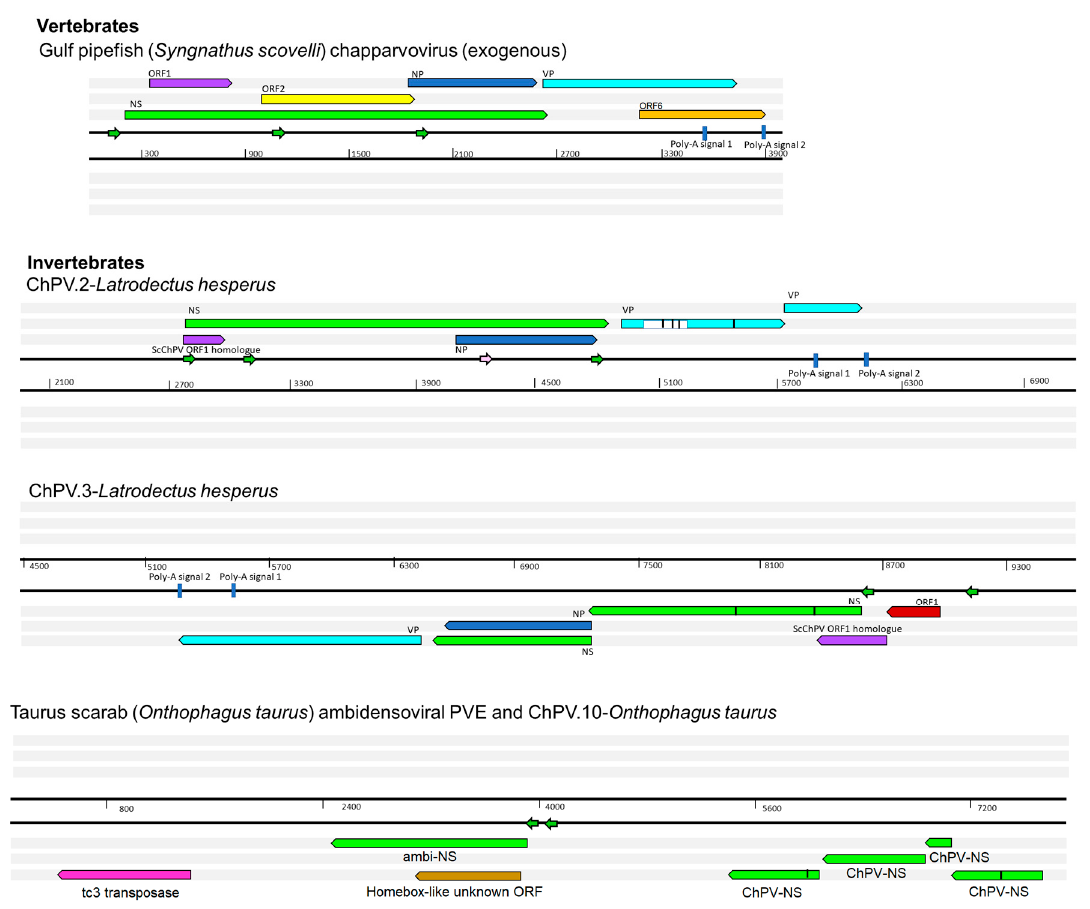
Figure 5. Genomic structures of newly identified chapparvoviruses (ChPVs) and ChPV-derived endogenous parvoviral element (EPV) sequences. The positions of putative open reading frames (ORFs) and predicted cis transcription elements of ChPVs are shown. ChPV.2-LatHes contains a previously unidentified repetitive element, present as multiple copies scattered in the Latrodectus genome, marked by the white box within the VP gene. The element ChPV.10-OntTau shares its integration site with another endogenous element, disclosing similarity to ambidensoviruses. ORFs are represented by rectangular arrows, colored according to homology. In-frame stop codons are shown as vertical lines. Splice donor sites are marked by white-colored bars, acceptor sites by orange-colored bars. Blue-colored bars show predicted polyadenylation signals. Small arrows show predicted promoters and are colored according to prediction score ( > 0.95 = green; 0.9–0.95 = pink: < 0.9 = yellow). Grey boxes indicate regions inferred to be transcribed but not